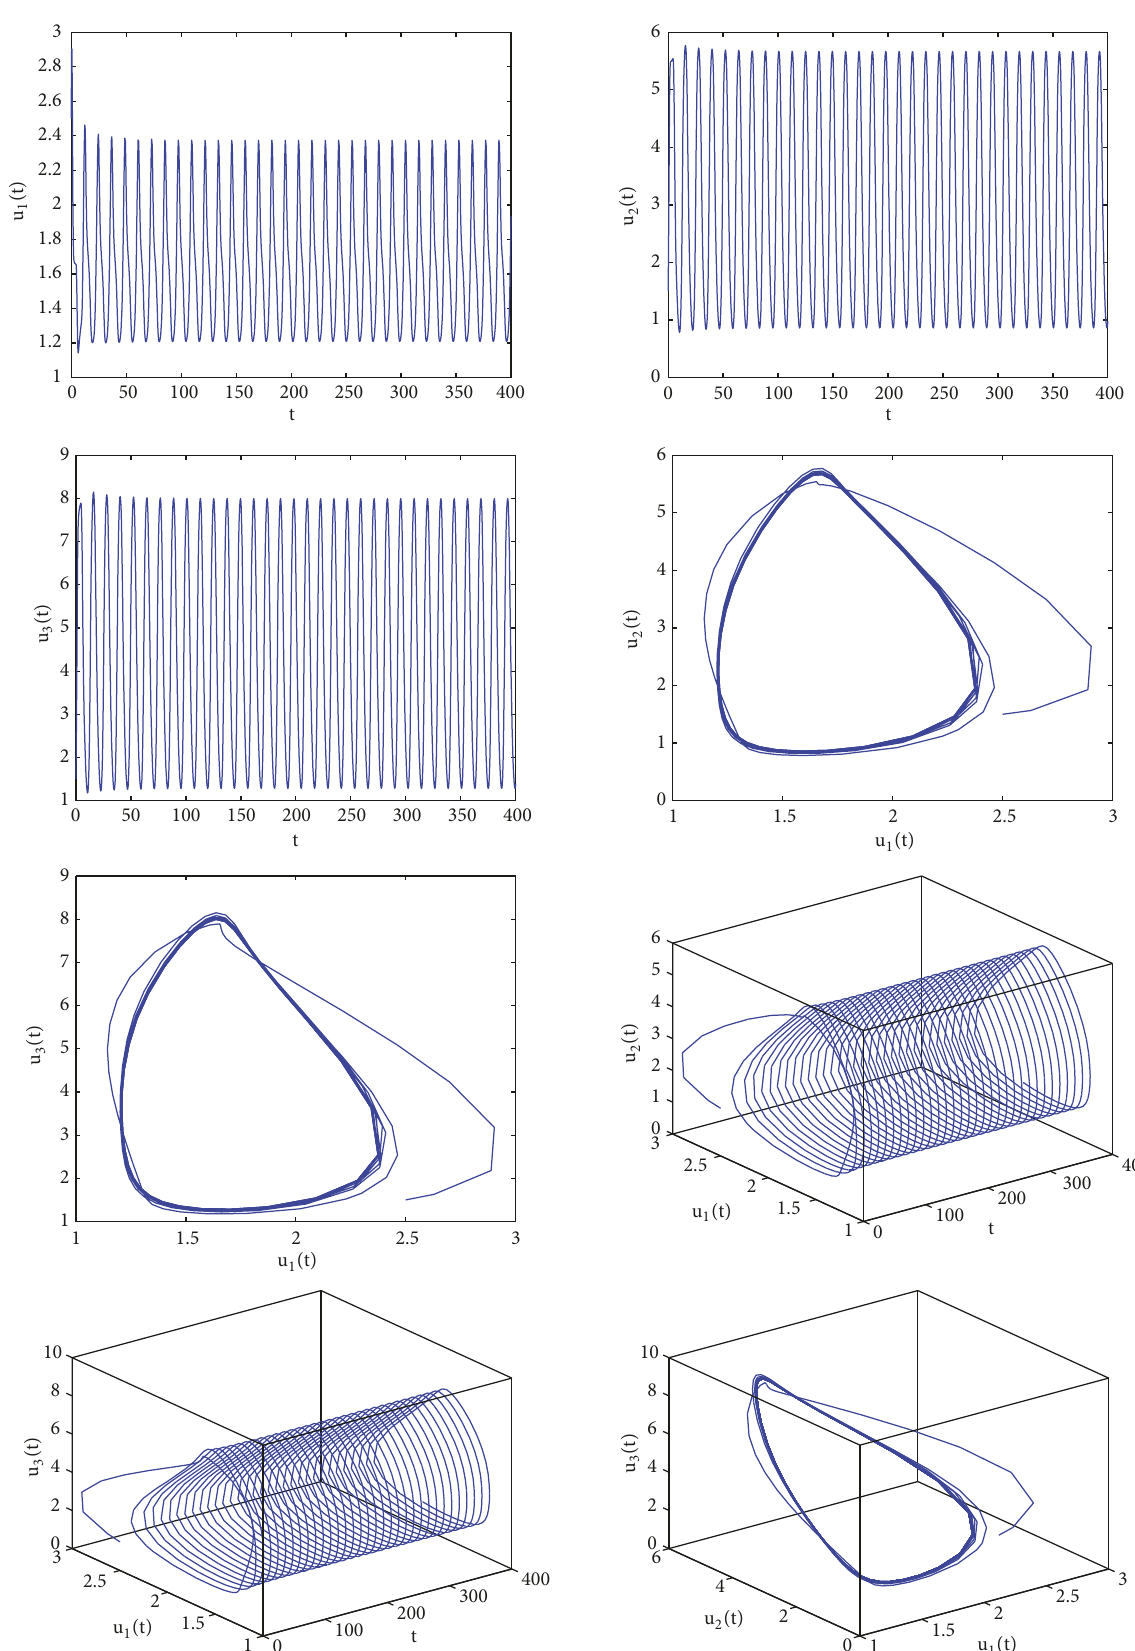
Figure 2: 𝜌 = 0.62 > 𝜌 0 = 0.5739. Hopf bifurcation of system (32) occurs from the positive equilibrium point (1.6471,2.9135,4.1621)